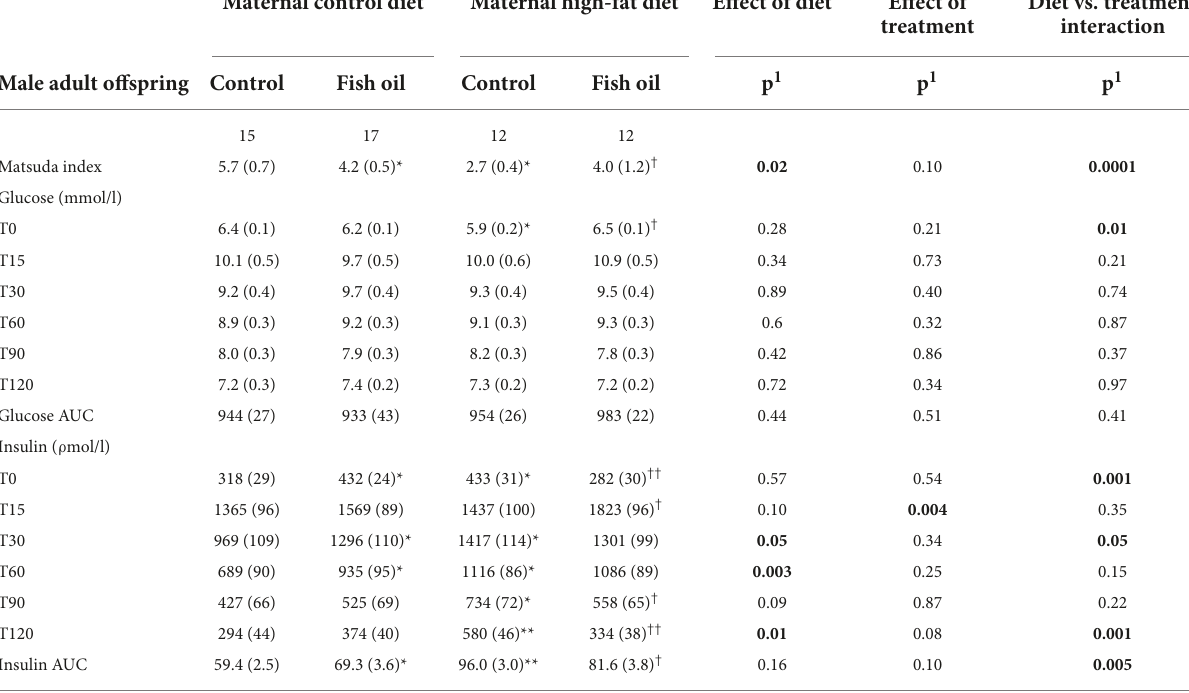
Diet vs. treatment treatment interaction